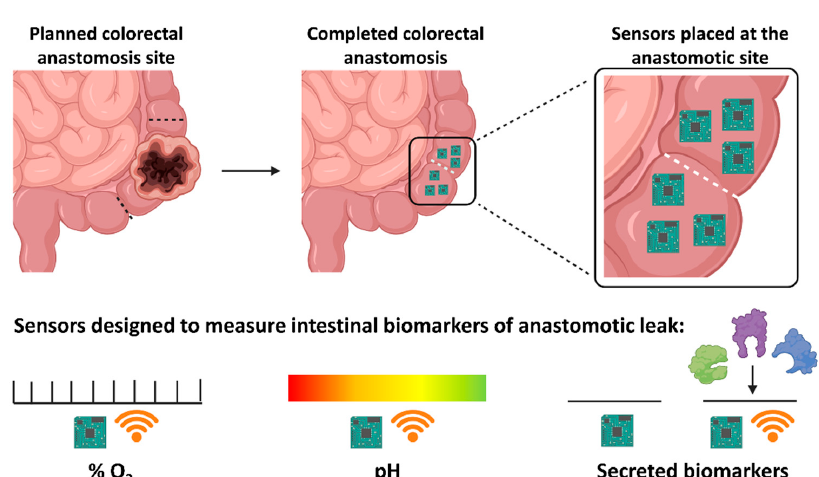
Figure 2. Future applications of advanced technologies for measuring anastomotic leak biomarkers. Implantable sensors placed intra-operatively around the anastomotic site could be left in situ throughout the post-operative recovery period. This concept would allow clinicians to continuously monitor peri-anastomotic biomarkers such as O 2 , pH, C-reactive protein, lactate and pyruvate levels. This type of continuous monitoring system would help to identify patients at risk of developing an AL due to poor or deteriorating peri-anastomotic intestinal ptO 2 . It would also allow clinicians the ability to assess the efficacy of interventions designed to improve intestinal ptO 2 and prevent a leak from occurring. Figure created in